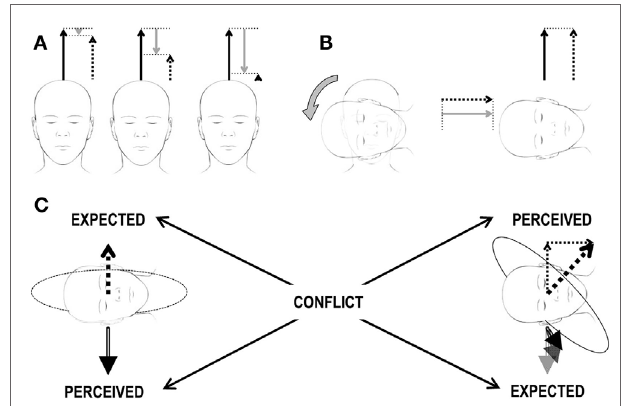
FiGURe 2 | Scheme of the Coriolis/cross-coupling stimulus and the induced sensory conflict . (A) Constant-velocity rotation. The three heads correspond to three subsequent time points during a constant-velocity rotation. The three arrows above each head correspond to the actual rotational velocity (solid black arrow), to the perceived velocity (dashed arrow), and to the amount of velocity decayed over time (gray arrow) due to the properties of the vestibular system. The sum of the solid black and gray arrows must always correspond to the dashed arrow. In the beginning (leftmost head), the subject has just been accelerated to the constant velocity. The perceived velocity (dashed arrow) is only slightly lower then the actual one (solid black arrow). As time passes (central and rightmost heads), the decayed velocity signal increases and the perceived velocity decreases. (B) Head tilt during constant-velocity rotation. Heads and arrows as in (A) after the tilt (rightmost head), no actual rotational velocity exists along the head vertical axis (no solid black arrow). However, as the decayed velocity is different from 0, the absence of an actual velocity leads to a perceived velocity different from 0 (recall that sum of the solid black and gray arrows must always correspond to the dashed arrow, so in the absence of a black arrow, the dashed arrow is equal to the gray arrow). The actual velocity is now along the head interaural axis and is perceived by the semicircular canals. The perceived velocity has, therefore, now two orthogonal components. (C) Brain expectations and conflict. Leftmost head: the perceived gravity signal (double-line, black arrow below the head) is stable. Accordingly, any expected perceived rotational velocity (dashed arrow above the head) must be aligned with the gravity vector. Rightmost head: the perceived rotational velocity is tilted by 45° (thick dashed arrow above the head) as it corresponds to the sum of the two perceived rotational velocity vectors in (B) (thin dashed arrows above the head). Accordingly, the gravity vector (double-line, black arrow below the head) should rotate in the head reference frame as the head changes orientation relative to gravity. Expected and perceived sensory signals do not match, leading to a sensory